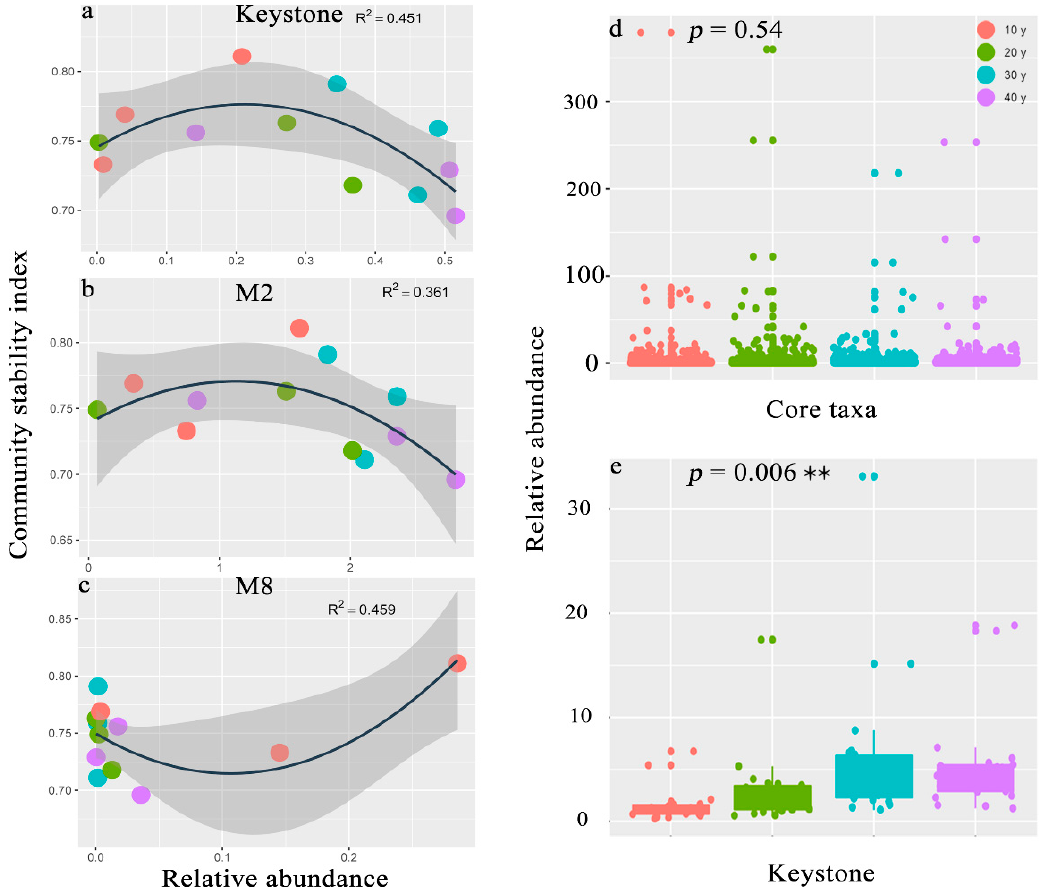
Figure 5. ( a – c ) Relationship between the assemblage stability index and the relative abundance of core taxa and keystone species (R 2 represents the correlation coefficient). ( d , e ) Boxplot of the relative abundances of core taxa and keystone species in the different recovery periods (the p value indicates the significance of ANOVA between the four recovery times, statistically significant ** p < 0.01).